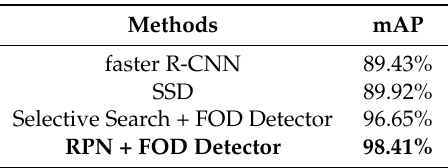
Table 5. The mean average